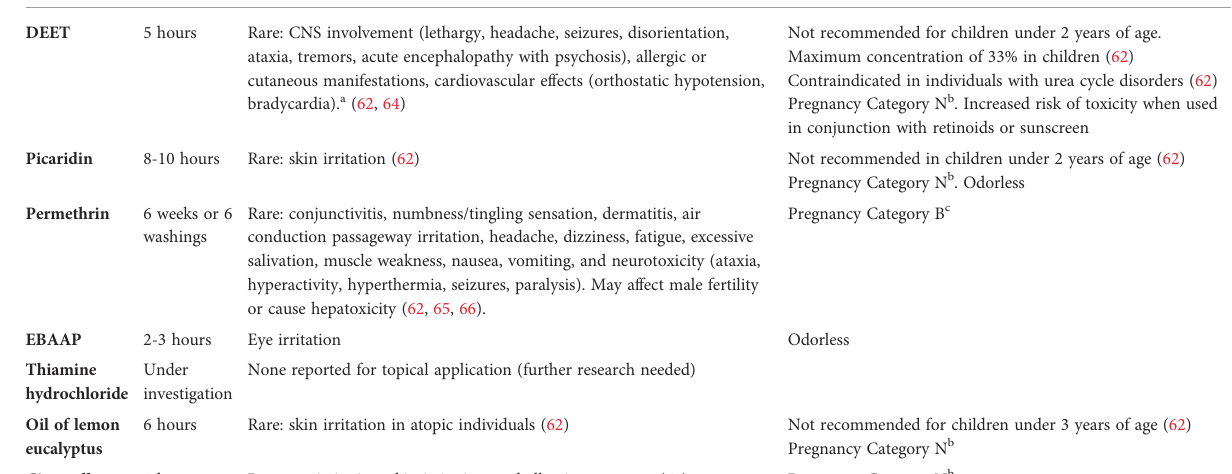
TABLE 1 Mosquito bite repellants and their safety pro fi le. Repellant Average Reported adverse reactions and duration